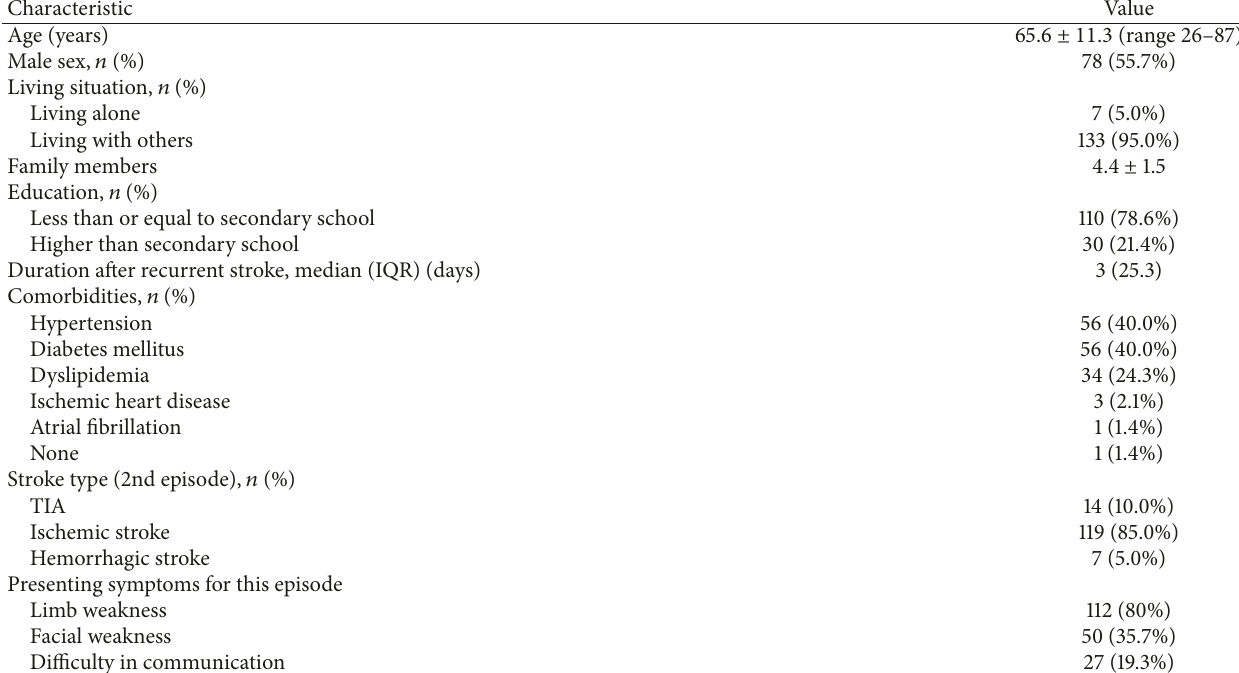
Table 1: Characteristics and demographic data of patients ( 𝑛 = 140